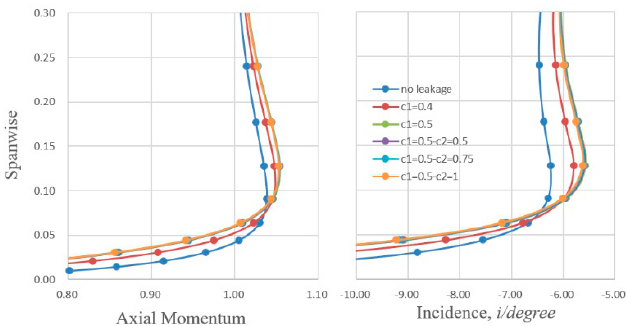
Figure 15. Spanwise distribution of blade element performance for Rotor 2.